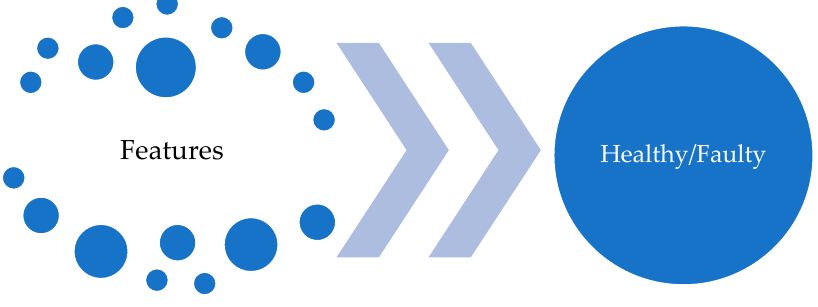
Figure 10. Input and output of the models.